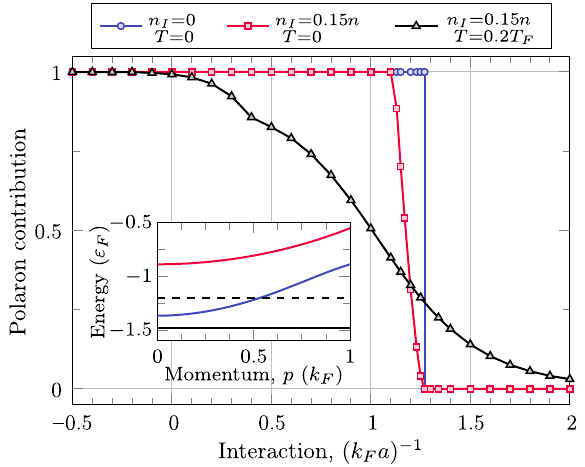
FIG. 7. Calculated polaron contribution. Fraction of impurity particles propagating as polarons as a function of interaction strength ð k F a Þ − 1 . The impurity particles which are not polaronic are bound to a bath particle, thus forming a molecule. In the single-impurity limit and T ¼ 0 (blue), there is a sharp transition between a polaron and a molecule at ð k F a Þ − 1 c ≈ 1 . 27 . Finite impurity density ( 0 . 15 n , red) leads to smoothing of the transition for ð k F a Þ − 1 < ð k F a Þ − 1 c . When the temperature is increased ( 0 . 2 T F , black), the polaronic branch is populated also for ð k F a Þ − 1 > ð k F a Þ − 1 c and the sharp transition disappears. The inset shows the polaron (blue line) and molecule (red line) dispersions for n I ¼ 0 . 15 n and ð k F a Þ − 1 ¼ 0 . 6 , along with the chemical potential at T ¼ 0 (dashed black line) and T ¼ 0 . 2 T F (solid black line). At T ¼ 0 . 2 T F , polarons and molecules are populated only by thermal excitations, while at T ¼ 0 the chemical potential is above the minimum of the polaron dispersion such that a well- defined polaronic Fermi surface